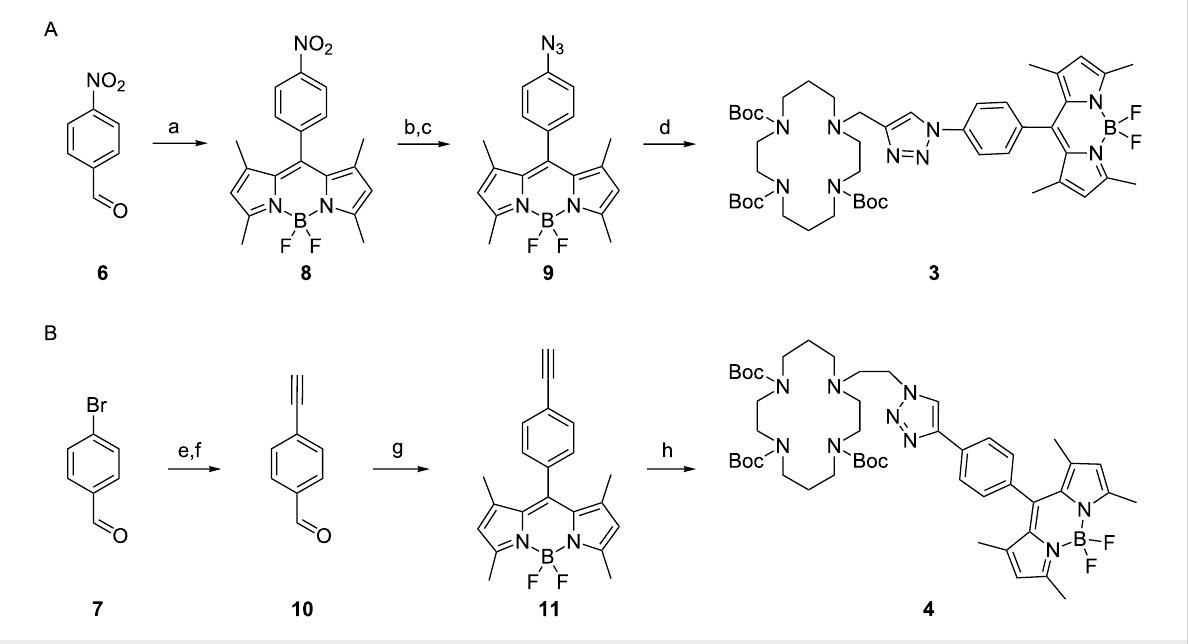
Scheme 2: Synthesis of the triazolyl-cyclam/ F -BODIPY conjugates 3 (A) and 4 (B). Reagents and conditions: (a) (i) 2,4-dimethyl-1 H -pyrrole ( 5 ), TFA, DCM, rt, overnight; (ii) DDQ, rt, 2 h; (iii) Et 3 N, BF 3 ·OEt 2 , rt, overnight, 27%; (b) NH 2 NH 2 ·H 2 O, 10% Pd/C, EtOH, reflux, 2 h, 90%; (c) (i) 1 M HCl (aq),